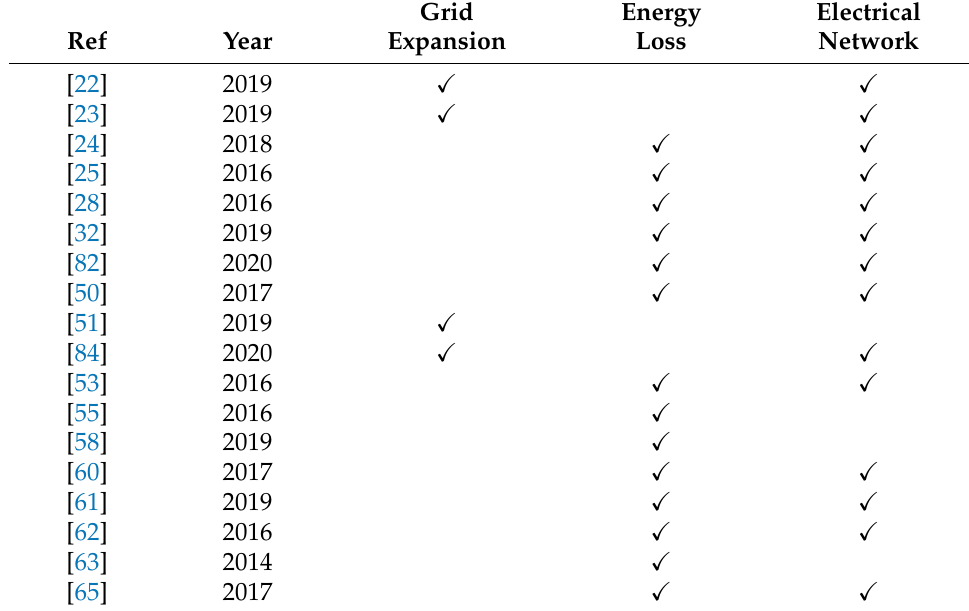
Table 6. Planning: DSO-oriented.